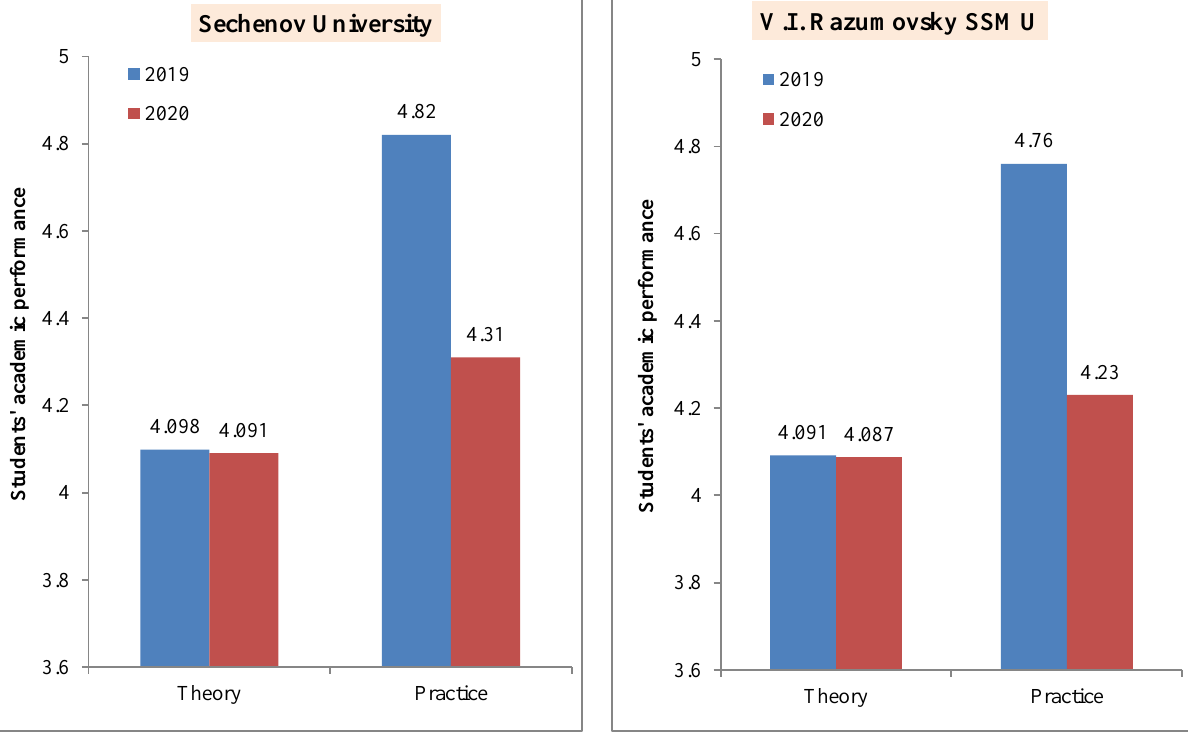
Figure 4. The average score of students' academic performance at Sechenov University and V.I. Razumovsky SSMU for 2019-2020. Note: ↓ A downward trend in academic performance indicators compared to 2019, p